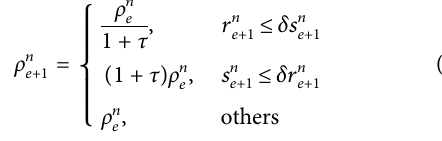
FIGURE 2 | Flow chart of the ADMM